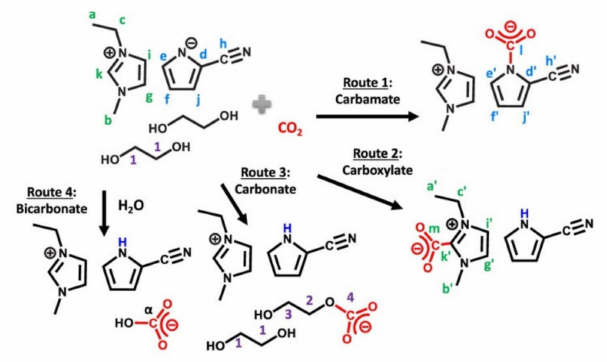
Figure 5. Proposed reaction network with NMR labeling of the reactants and CO 2 bound products. (Reprinted with permission from Ref. [74]. Copyright (2021) American Chemical